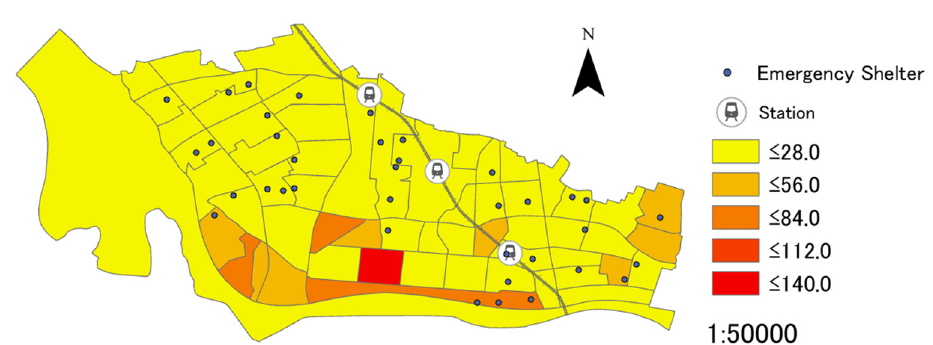
Figure 11. Result for Toda City without a weighted coefficient was not used.